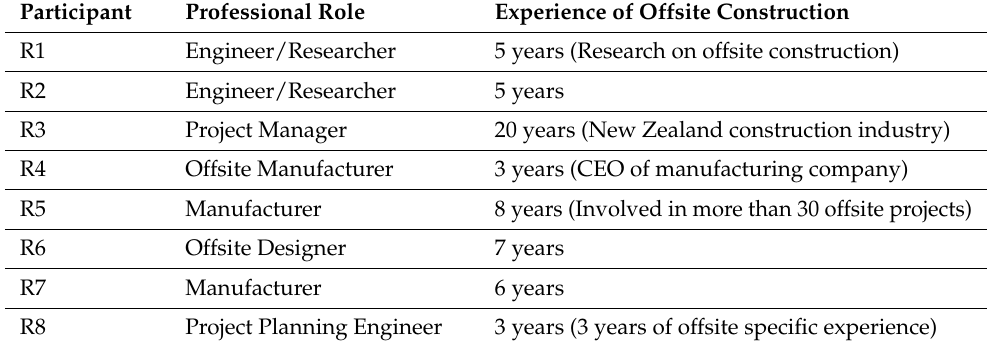
Table 3. Interviewees